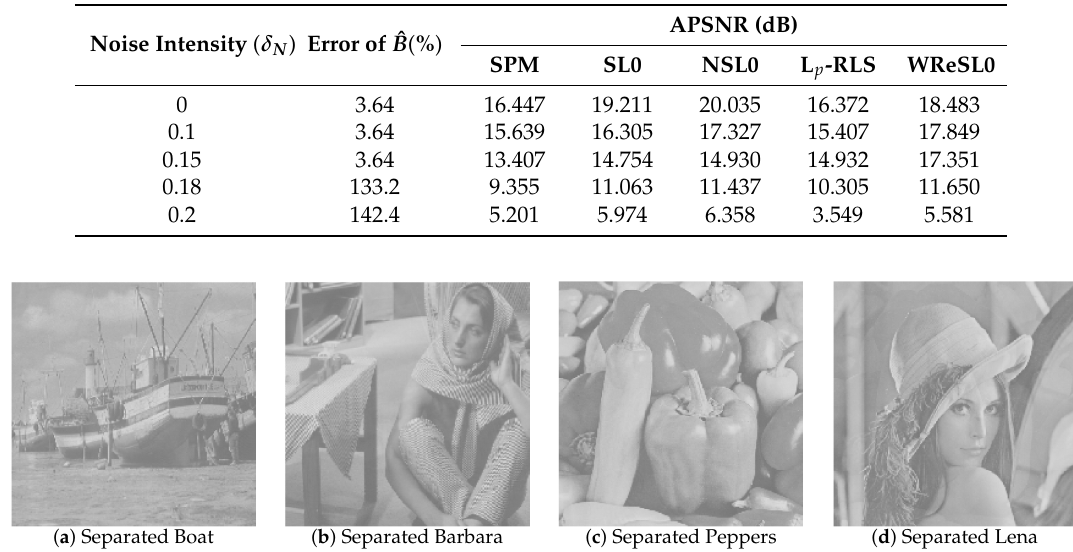
Table 6. APSNR analysis for separated images by SPM, SL0, NSL0, L p -RLS, and the proposed WReSL0 with δ N changing according to the sequence [0,0.1,0.15,0.18,0.2] with 100 runs.